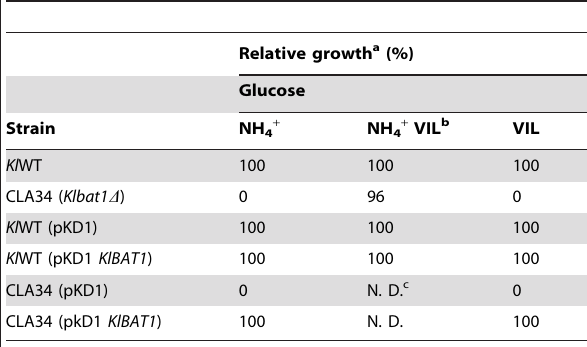
Table 1. Klbat1 D mutants are impaired in VIL biosynthesis and